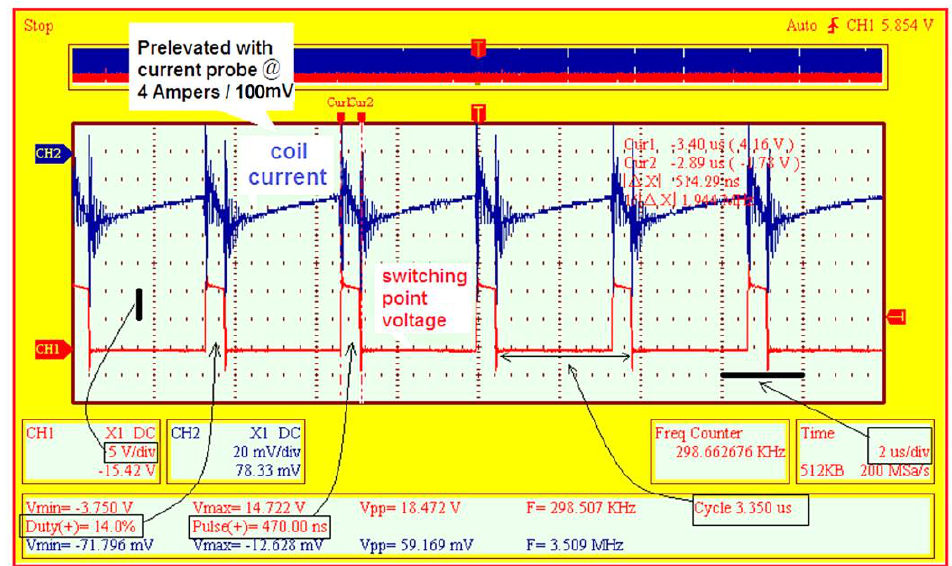
Figure 7. Coil current and switching point voltage waveforms on the DSO (digital storage oscilloscope) that validate the functioning of the converter in CCM (continuous conduction mode).